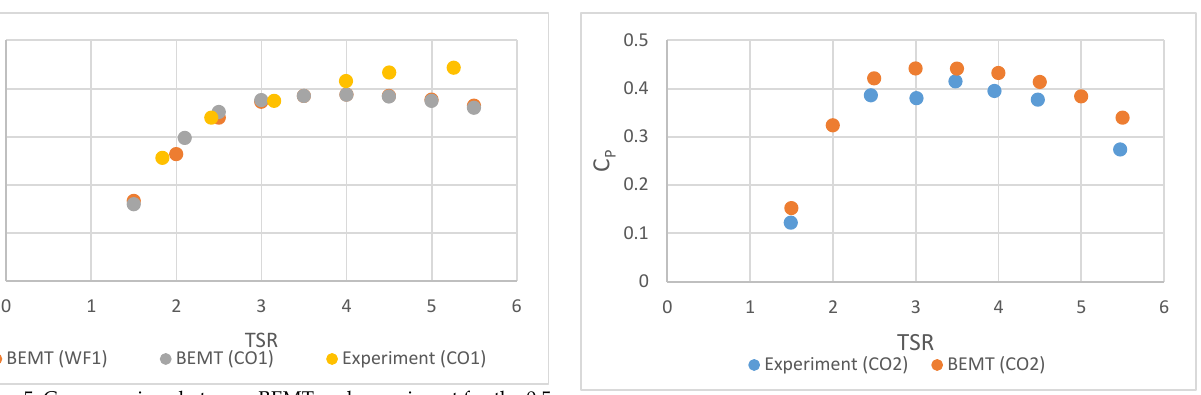
Figure 7. C P comparison between BEMT and experiments undertaken at Insean for the 1.0 m/s case when the turbine operates under current only conditions.